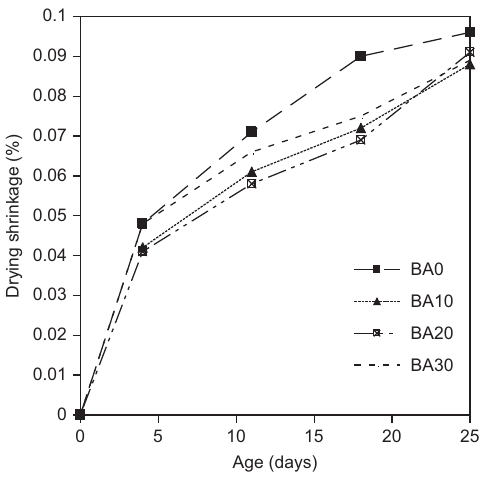
Figure 4 Drying shrinkage vs. age.